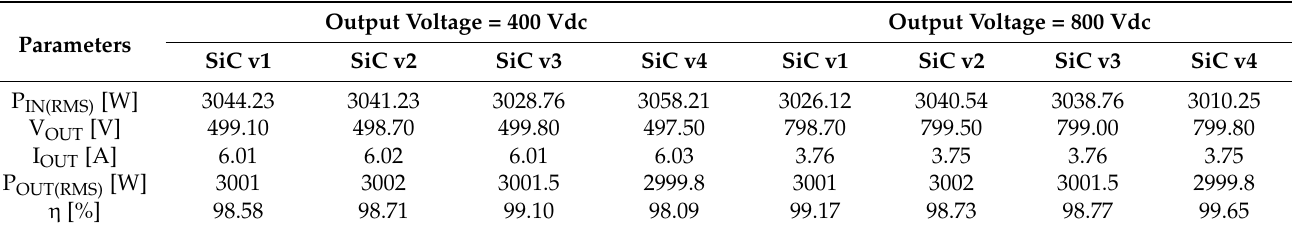
Table 3. Efficiency measurement results.